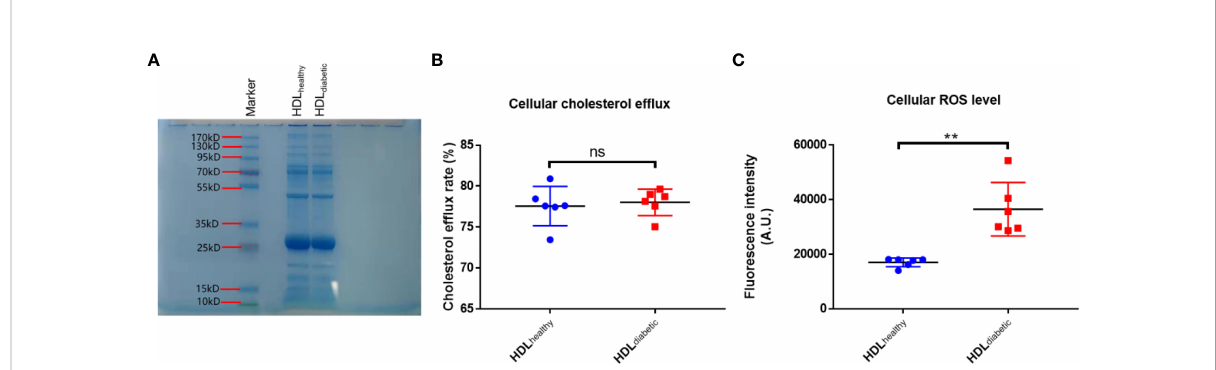
FIGURE 1 Analysis of the pro-oxidative activity of HDLs from diabetic patients. (A) SDS-PAGE analysis of HDLs puri fi ed by the sulfate dextran precipitation method. Ten micrograms of HDL puri fi ed using a commercial kit was loaded on a 4-20% Bis-Tris gel and stained with Coomassie Brilliant Blue dye. (B) Comparison of cholesterol ef fl ux capacity of HDL from diabetic patients and healthy controls. Differentiated THP-1 cells were loaded with NBD-cholesterol for 4 h, then treated with 100 ug/mL HDL from healthy controls (n=6) or diabetic subjects (n=6) for another 4 h. The fl uorescence intensity in cells and in the medium was determined. Cholesterol ef fl ux rate was calculated by dividing the fl uorescence intensity in the medium by the sum of fl uorescence intensity in the medium and cells. (C) Comparison of the level of ROS in HAECs treated with HDL from healthy subjects and diabetic patients. HAECs were pre-incubated with 10 uM DCFH-DA for 20 min, then treated with 500 ug/mL HDL from healthy controls (n=6) or diabetic subjects (n=6) for 30 min. The intracellular fl uorescence intensity produced by DCF was determined. ns: not signi fi cant. ** p < 0.01, ns: not signi fi cant. p value was obtained from analysis of paired Student ’ s t